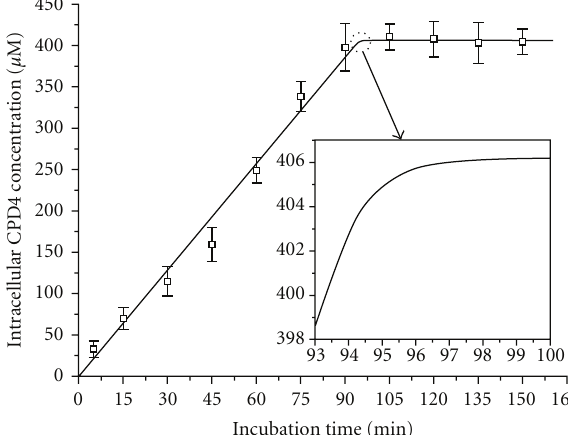
Figure 5: Total concentration of CPD4 in MCF-7 cells as a function of the incubation time. (cid:2) : total concentration of CPD4 calculated from the experimental data; —: the fitting